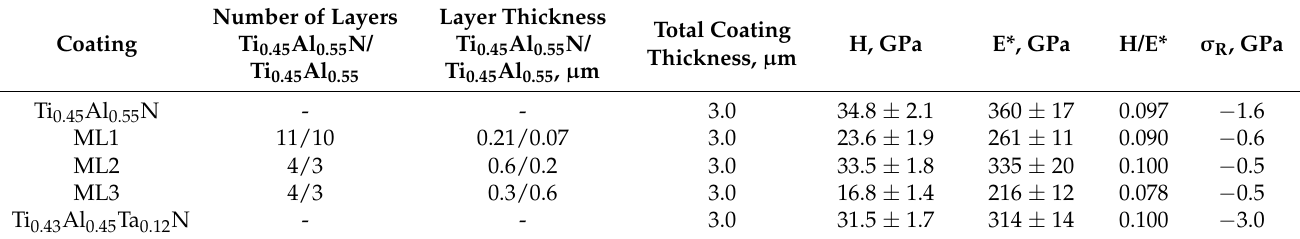
Table 1. Number and thickness of layers, and mechanical properties of the